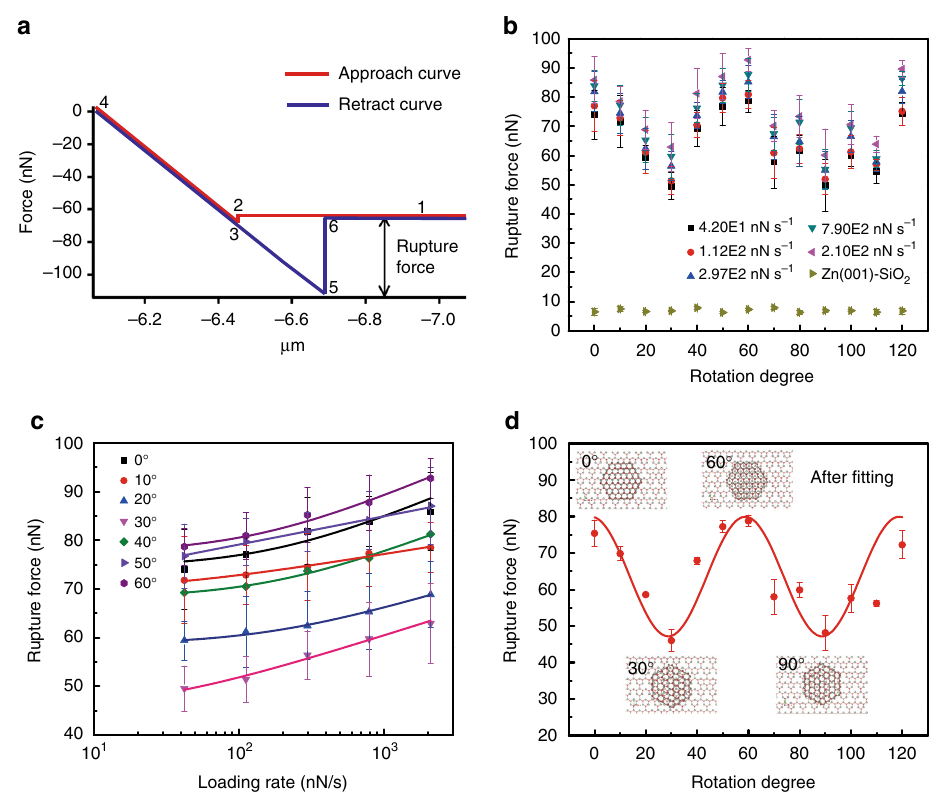
Fig. 2 Face-speci fi c interaction force measurements. a Representative force curves for ZnO(0001)-ZnO(0001) interaction in saturated aqueous solution. Point 1 – 2 presents the approach process until the jump-to-contact happened (point 2 – 3); then further push the tip to contact the substrate from point 3 – 4; after a short time to stabilize the interaction, tip retraction was performed (point 4 – 5) until a jump-from-contact happened (point 5 – 6). b Direction-speci fi c interaction forces at different azimuthal orientation for ZnO(0001)-ZnO(0001) and ZnO(0001)-SiO 2 /Si and different loading rates for ZnO(0001) – ZnO (0001). c Data fi tting for the different loading rates at each azimuthal orientation from 0° to 60° to obtain the equilibrium rupture force. Error bars in b and c represent the s.e. ( n = 25). d Rupture forces at different azimuthal orientation after fi tting using the multiple bond model developed by Friddle et al. 29 ; Error bars derived from the fi tting of the multiple bond model. Inset illustrates corresponding structure relationships between the tip and substrate crystals at selected azimuthal orientations (0°, 30°, 60°, and